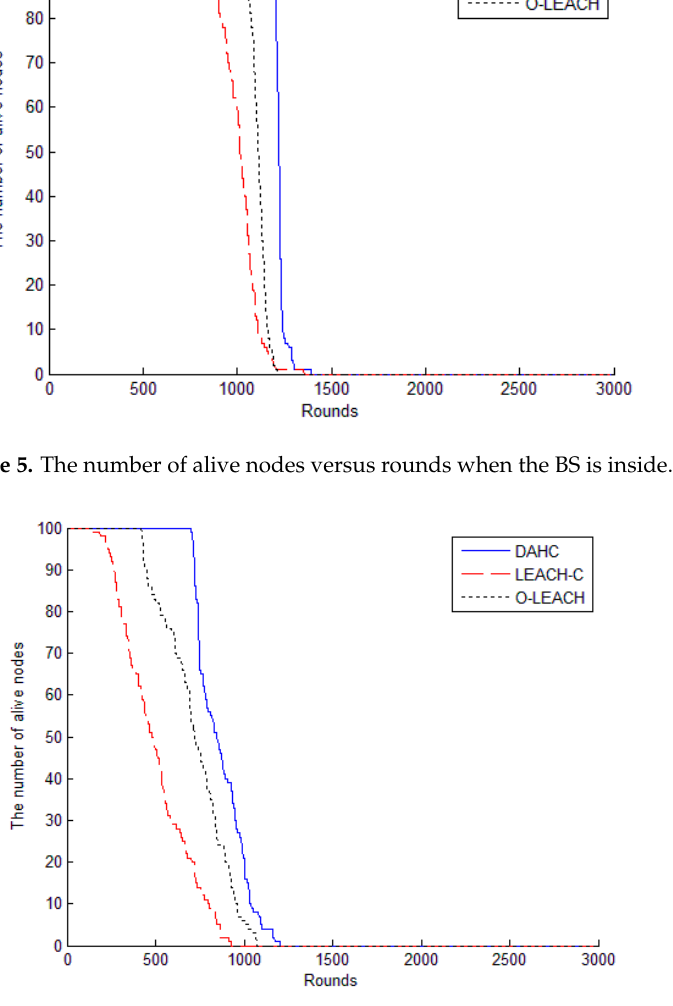
Table 4. The round of the FND (first node dies) when the BS is inside.